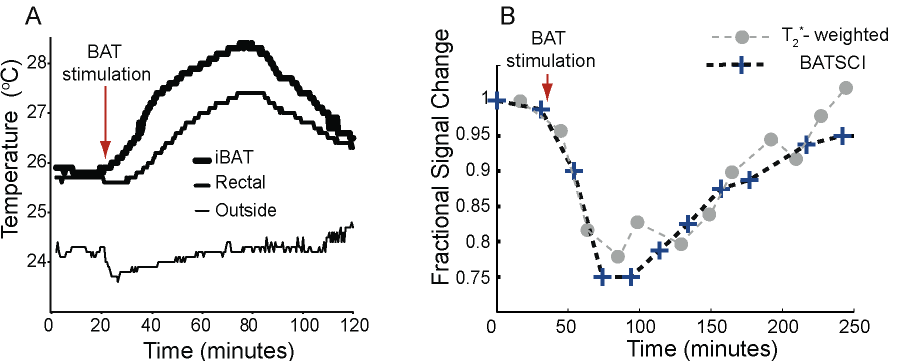
Figure 6. Detection of BAT activity with the BATSCI signal. ( A ) Temperature behavior of BAT in a healthy balb/c mouse after stimulation by NE injection showing the effect of the drug. After the injection of the BAT stimulant BAT temperature rises followed by rectal temperature ( B ) BATSCI signal intensity and T2* -weighted signal intensity from the interscapular BAT as function of time, before during and after stimulation of BAT by NE.